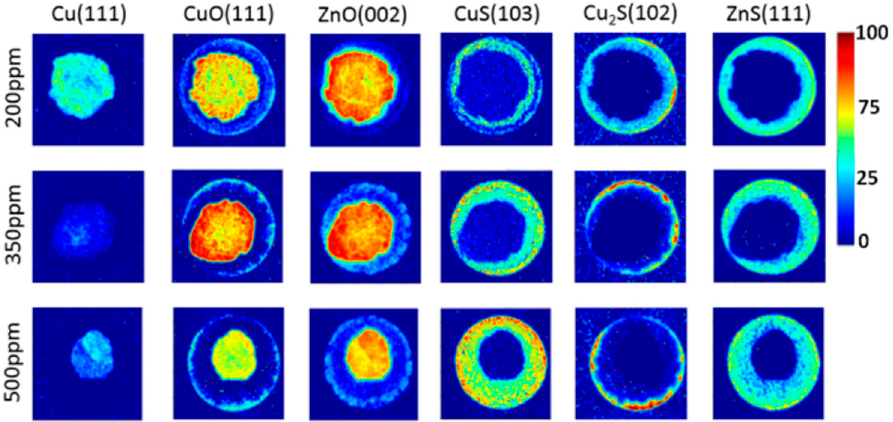
Figure 3. XRD intensity color maps showing different spatial distributions of sulfur-containing species. The analyzed sample is a microtomed cross section of a catalyst pellet (100 µ m thick). On the right-hand side is a thermal scale bar. Reprinted with permission from [58].